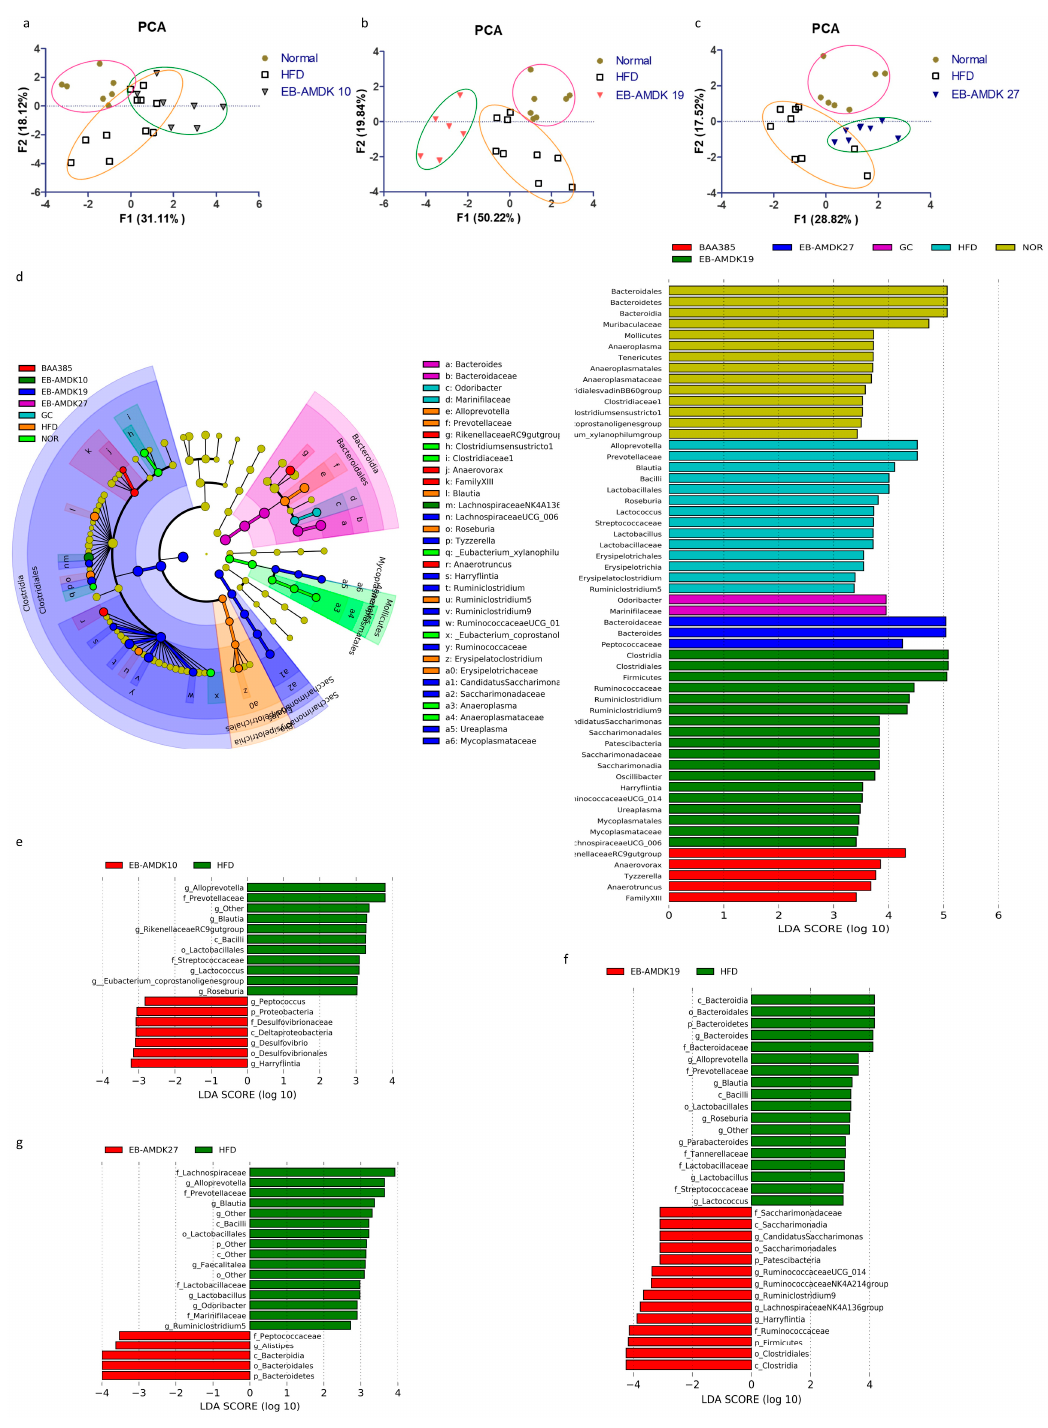
Figure 8. Effects of A. muciniphila strains on the gut microbiota composition. The gut microbiota was determined by 16S rRNA gene analysis of fecal samples from the mice. ( a – c ) Principal component analysis (PCA) of the gut microbiota metagenomic samples. ( d ) Cladogram generated by LEfSe analysis. The LEfSe plot shows enriched bacteria in all phenotypic categories. ( e – g ) LEfSe was used to identify the bacteria differentially represented between EB-AMDK 10 and HFD ( e ), EB-AMDK 19 and HFD ( f ) and EB-AMDK 27 and HFD ( g ). Only the taxa meeting a linear discriminant analysis (LDA) score threshold of two are listed. On the other hand, treatment of the HFD group with EB-AMDK 27, but not the other A. muciniphila strains, increased and decreased the abundances of Bacteriodales and Clostridiales